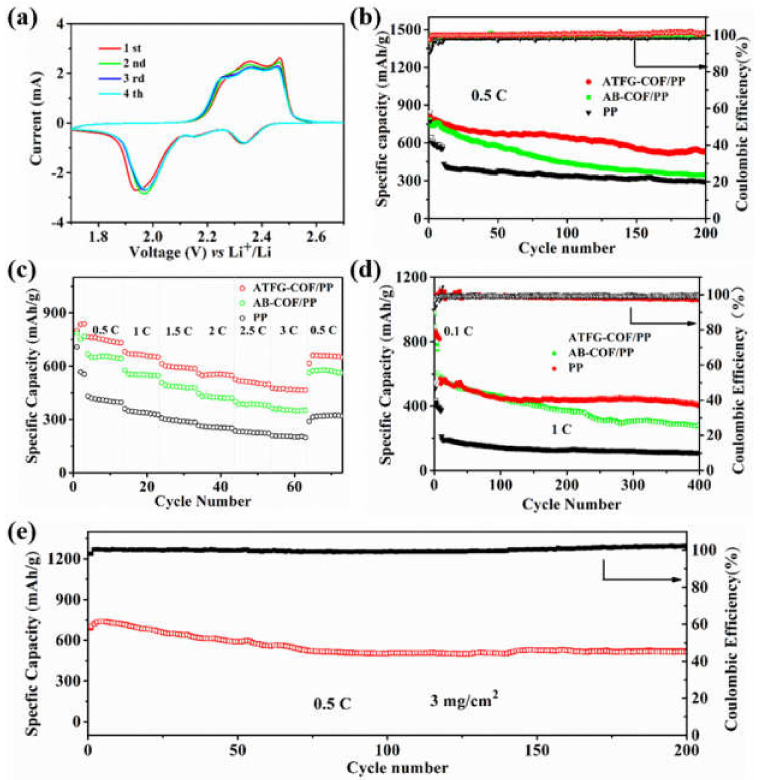
Figure 6. ( a ) CV curves of the Li-SeS 2 cells with ATFG-COF/PP at 0.1 mV s − 1 ; ( b ) cycle performance, at 0.5 C, of the different separator coatings; ( c ) rate performance of Li-SeS 2 cell with different separator coatings; ( d ) cycle performance of Li-SeS 2 cell with different separator coatings at 1 C; ( e ) cycle performance of Li-SeS 2 cell with different separator coatings at 0.5 C and 3 mg cm − 2